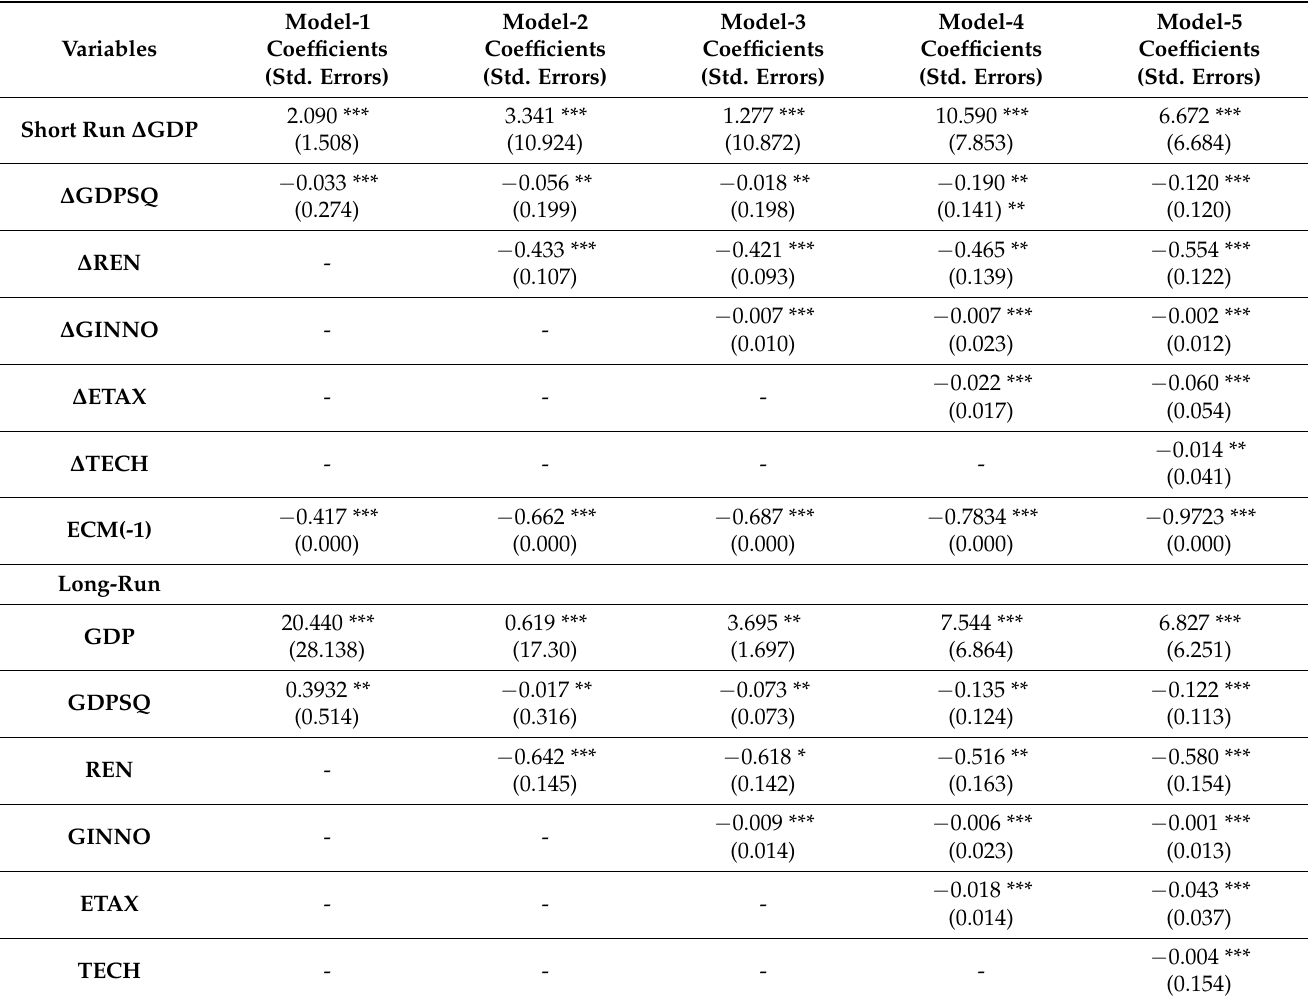
Table 6. Dynamic common correlation effect by (Chudik and Pesaran